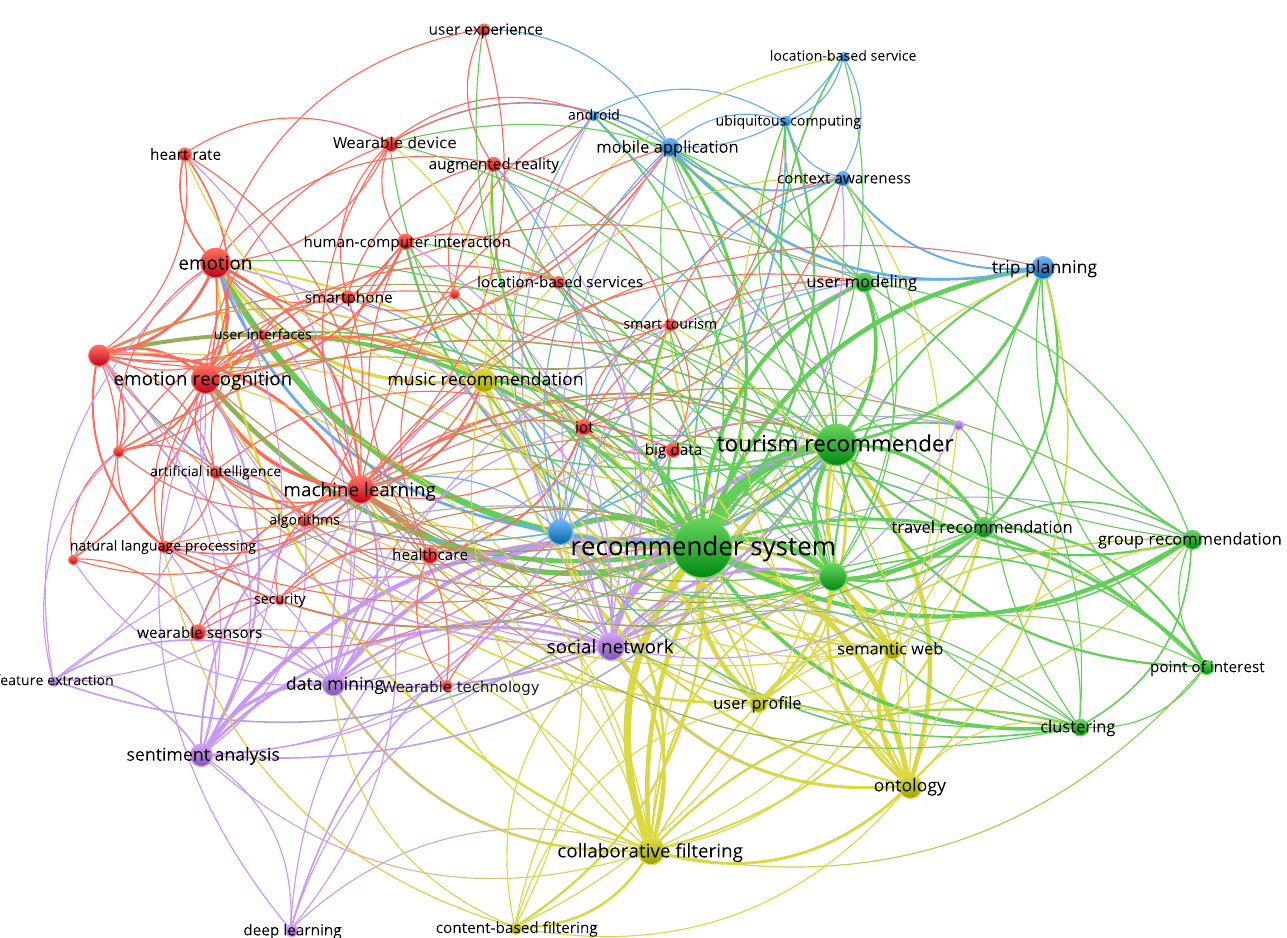
Figure 9. It is a co-occurrence network mapping of author keywords related to the RS, tourism, ER, and ML. Also, it displays five color clusters made up of nodes identified by labels. The grouping of relevant documents defines the nodes’ size and the lines between the